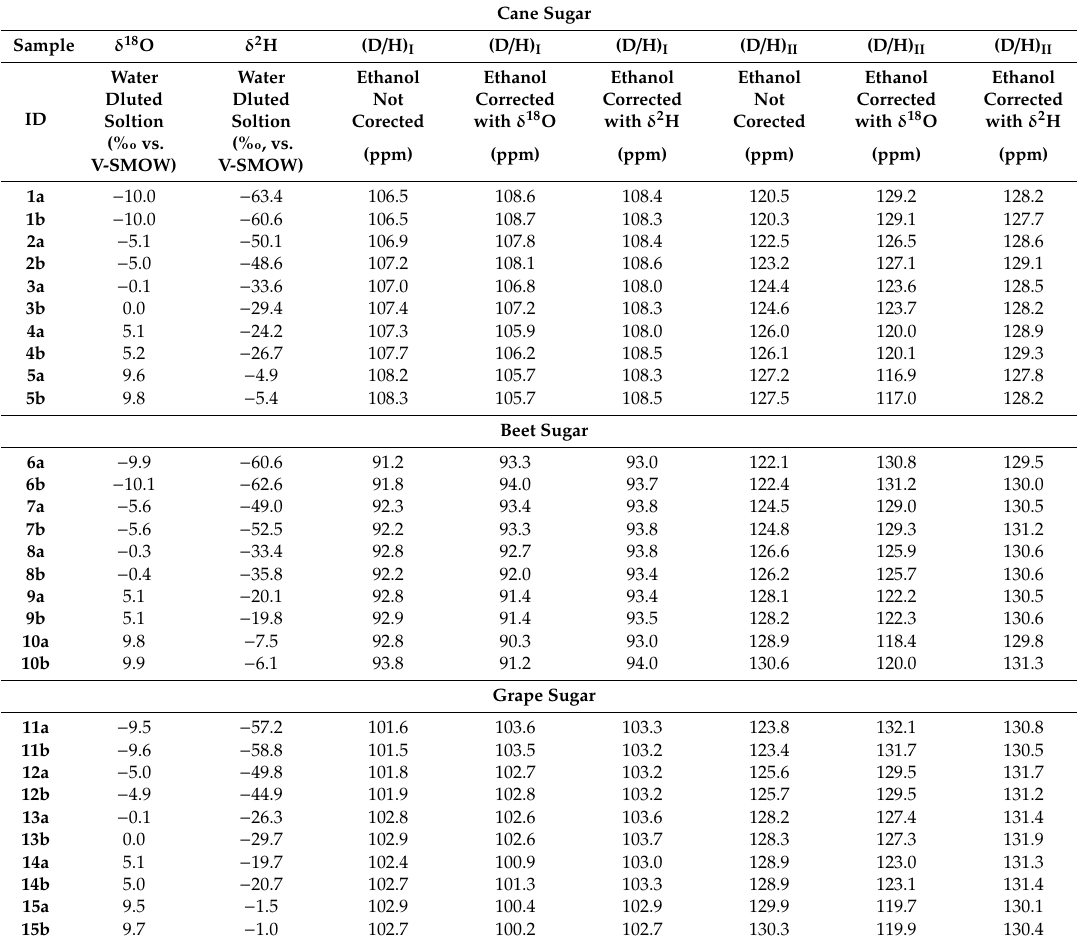
Table 1. δ 18 O and δ 2 H values of diluted sugar samples and of deuterium and hydrogen ratios (D / H) I and (D / H) II of ethanol obtained after fermentation of the three di ff erent sugars without correction and after correction using δ 18 O and δ 2